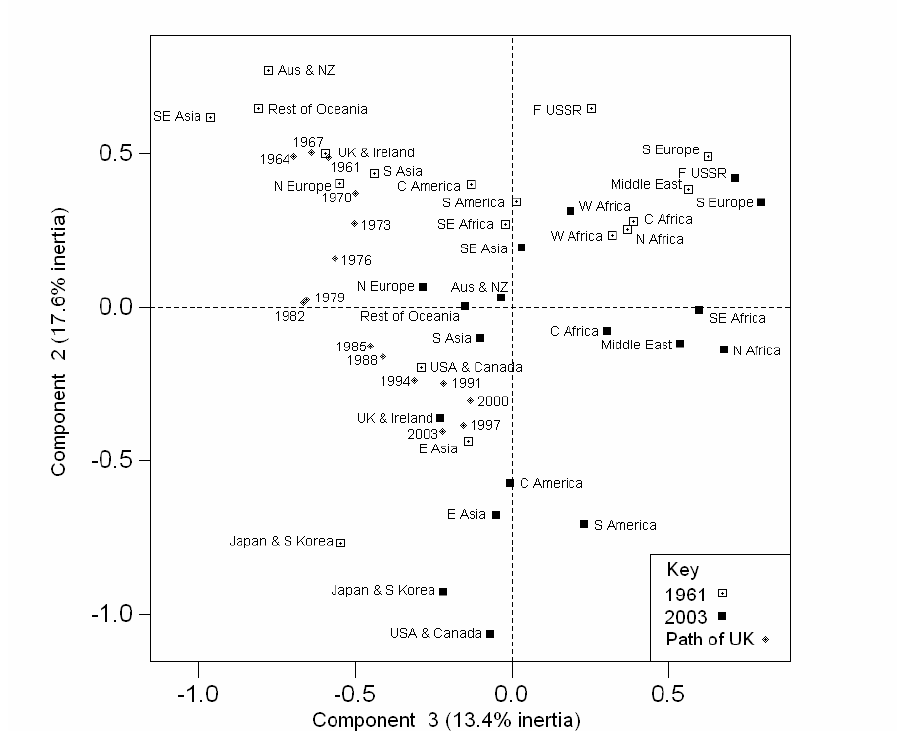
Figure 1b: Correspondence analysis – world regions plotted by the availability of different edible lipids in 1961 and